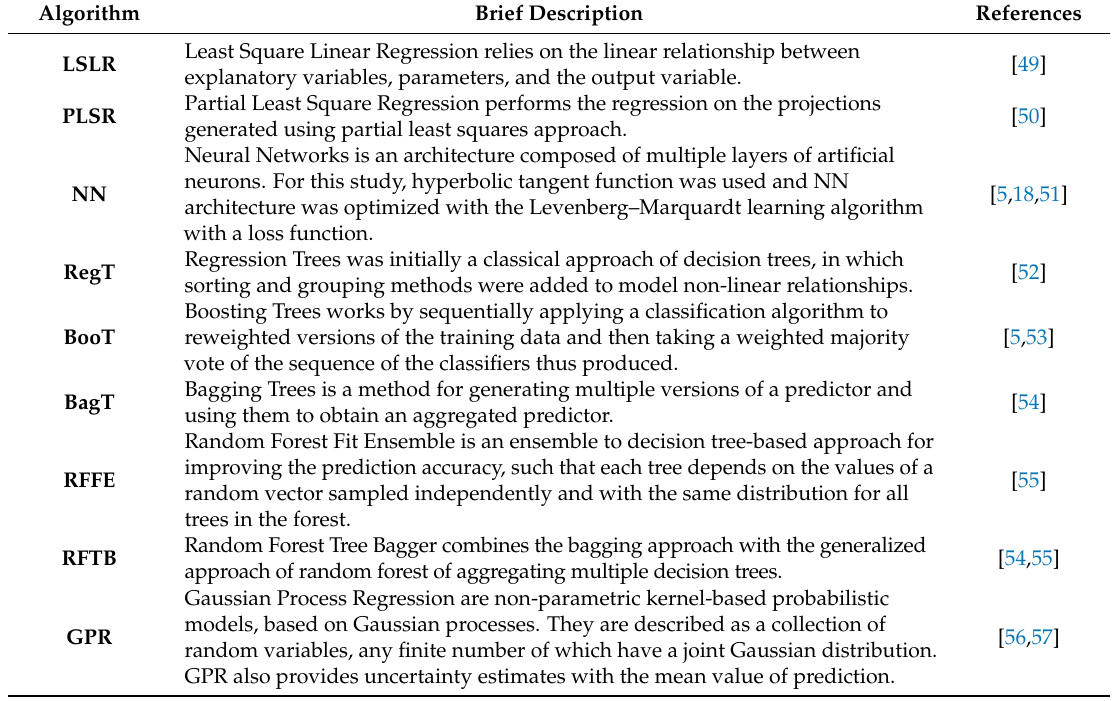
Table 2. Summary of the algorithms compared in this